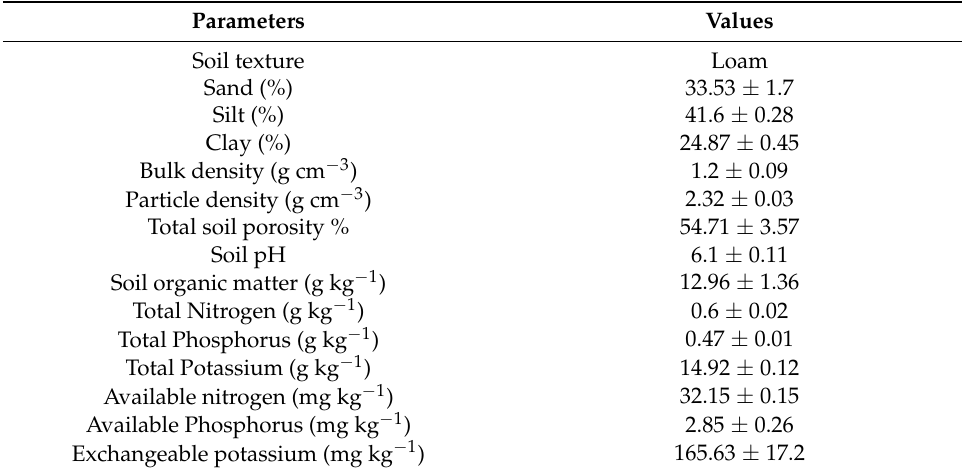
Figure 2. Experimental pot setup. Table 1. Physical and chemical soil